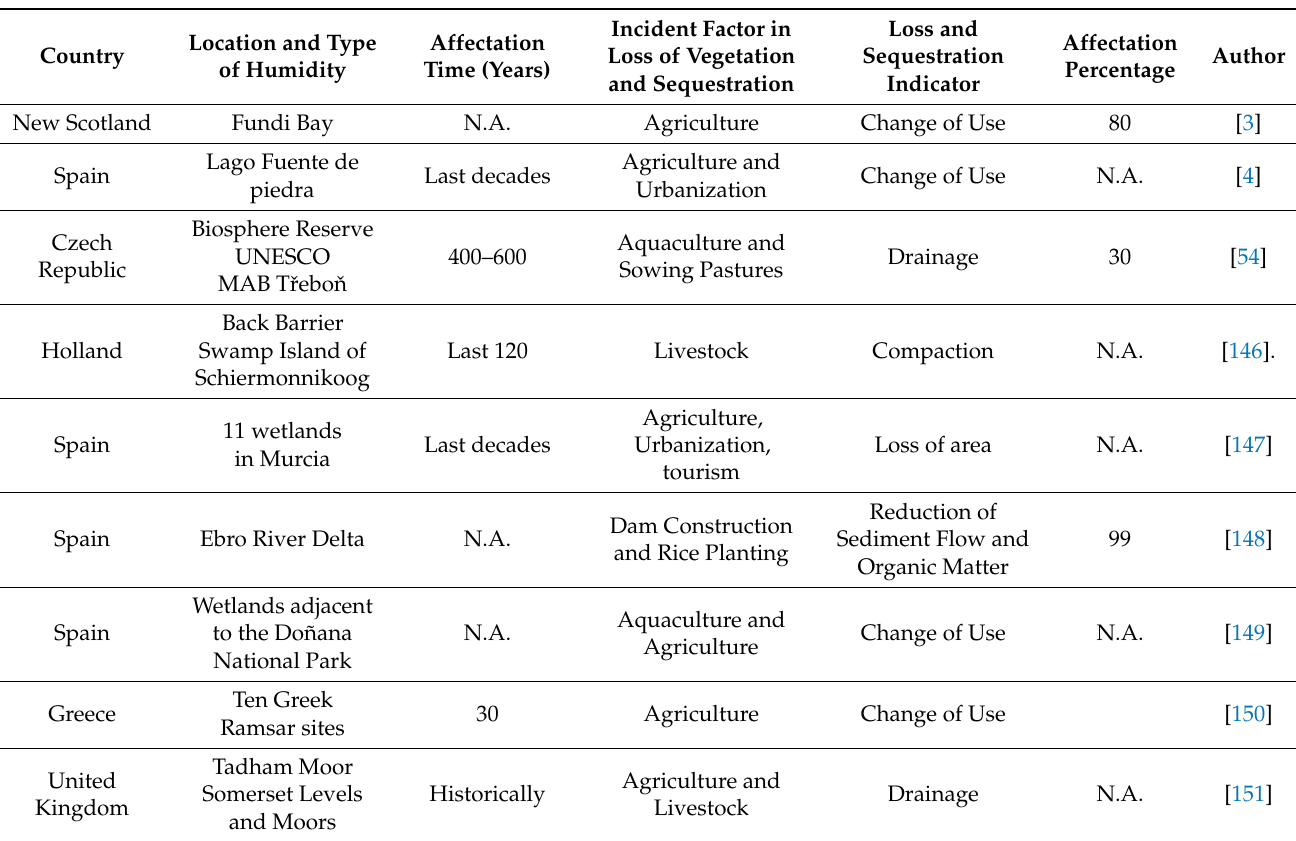
Table 4. Data from the European continent on wetlands in coastal, marine, and continental areas (n =